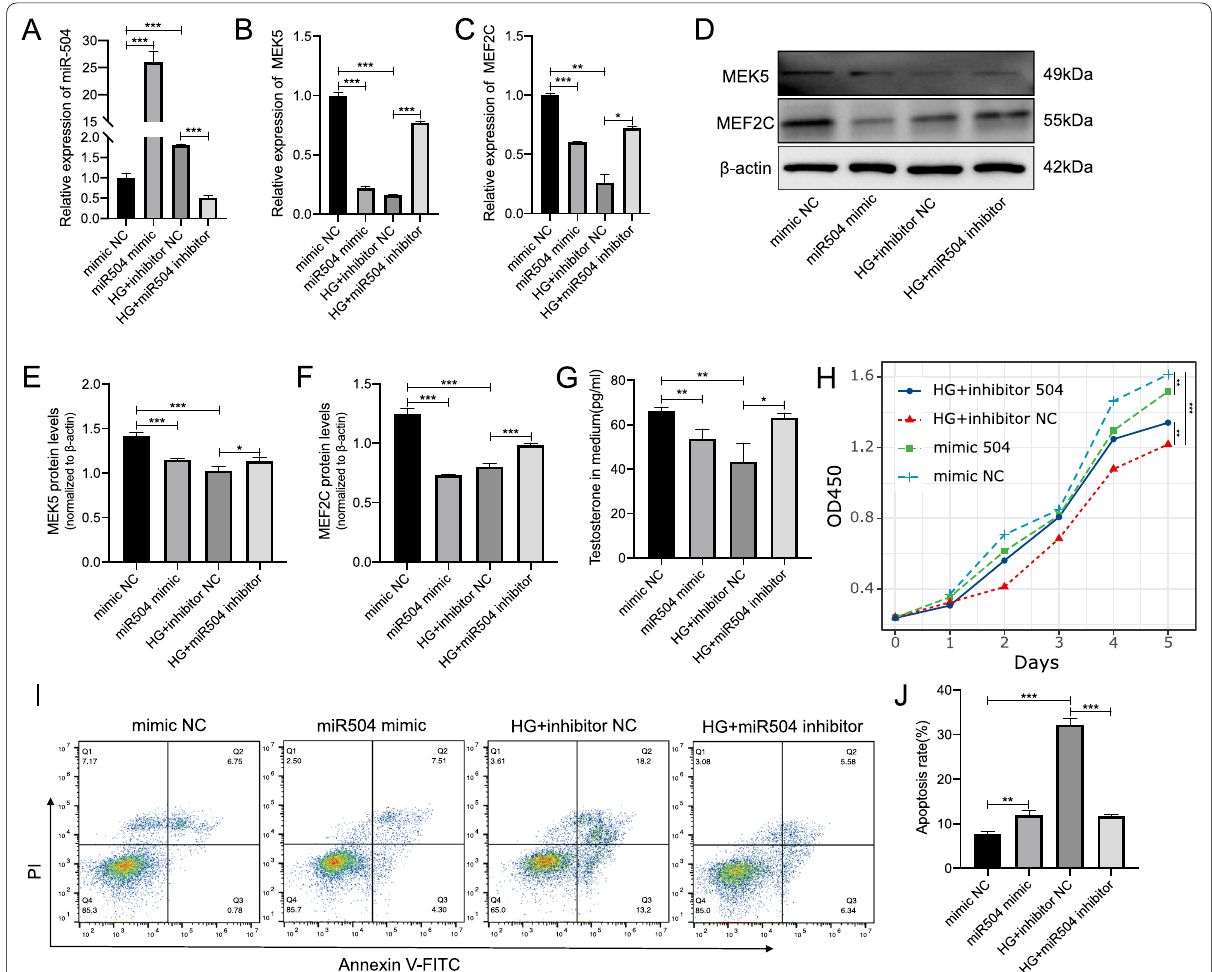
Fig. 5 Modulation of proliferation and apoptosis of Leydig cells by mRNA targets of miR-504. Expression of miR-504 in miR-504 mimic-or miR-504 inhibitor-infected R2C cells at 24 h after culturing in normal or high glucose (HG). Data were normalised to U6 RNA, used as an internal control ( A ). Expression of MEK5 and MEF2C determined by RT-qPCR analysis. β-actin was used as an internal control ( B , C ). Representative immunoblotting ( D ) and cumulative quantification ( E , F ) of the protein levels of MEK5 and MEF2C in R2C cells transfected with miR-504 mimic, miR-504 inhibitor, mimic NC, or inhibitor NC. Media were collected and assayed for concentration of testosterone using ELISA ( G ). Cell proliferation was assayed using CCK8 ( H ). Detection of apoptotic cells by FACS analysis with FITC-labelled annexin V and PI staining ( I ). Bar graphs represent the percentage of apoptotic cells in each group (J). *p < 0.05, **p < 0.01, ***p < 0.001. n =